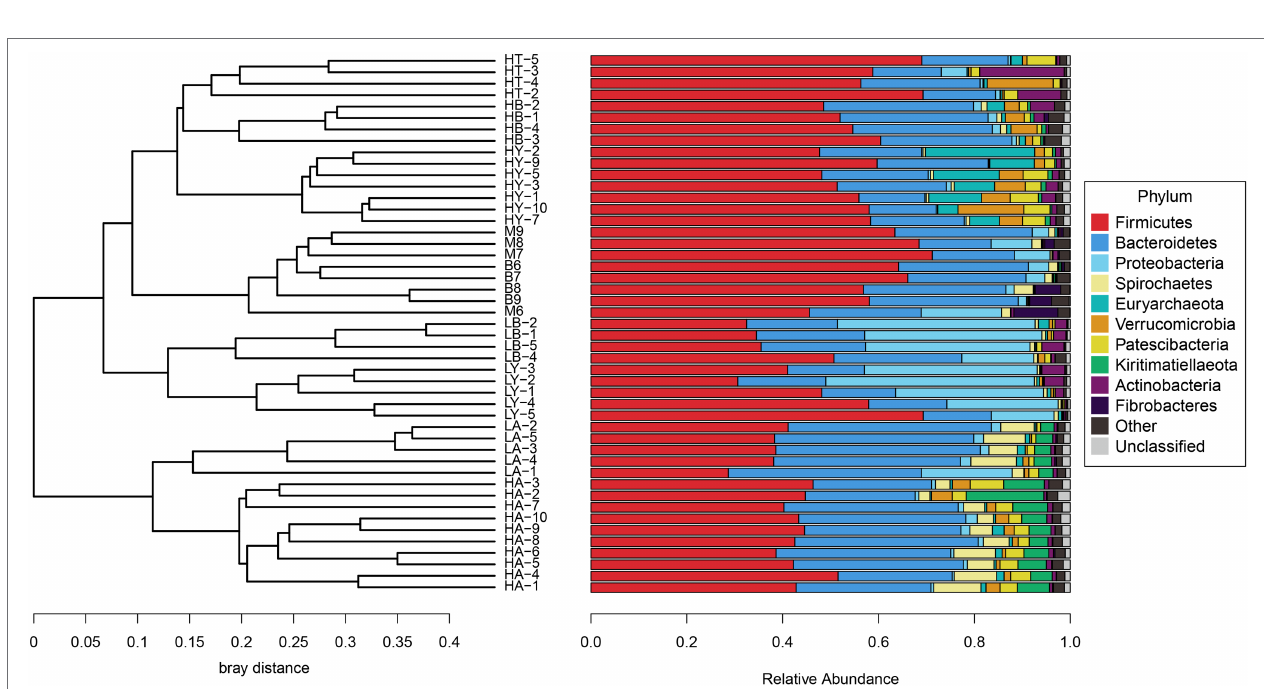
FIGURE 1 | Species accumulation boxplot (A) and rarefaction curves (B) . In the species accumulation boxplot, the abscissa is the sample size, and the ordinate is the observed species. In the rarefaction curves, the abscissa is the number of sequencing samples randomly chosen from the sample, and the ordinate is the number of OTUs